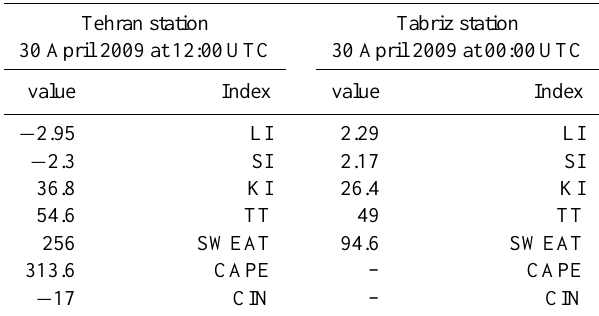
Table 2. Instability indices for Tehran and Tabriz stations on 30 April 2009. Tehran station Tabriz station